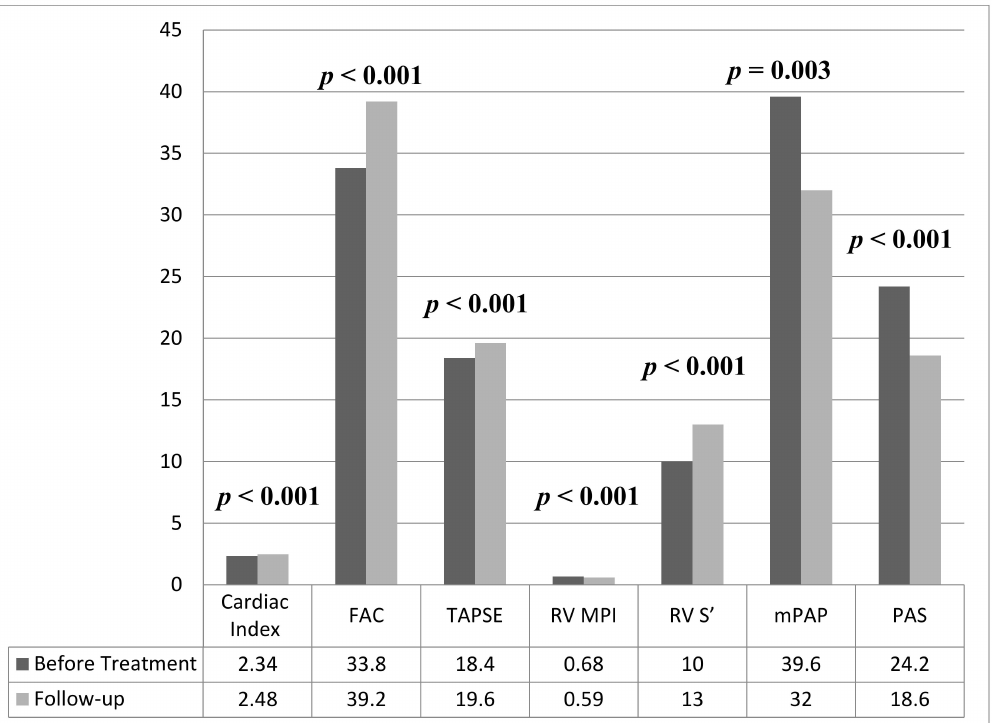
Figure 2. Changes in right ventricular functional assessment and pulmonary arterial stiffness mea- surements before and after SGLT2 inhibitor treatment at the 6-month control period. FAC fractional area change, TAPSE tricuspid annular plane systolic excursion, RV MPI right ventricle myocardial performance index, mPAP mean pulmonary artery pressure, and PAS pulmonary arterial